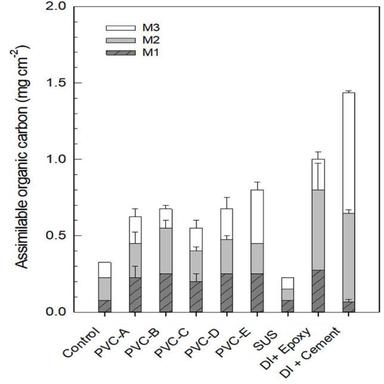
Assimilable organic carbon migration potential for the selected pipe materials at 25 ◦C. M1, M2, and M3 represent three test cycles (3 d per cycle). The tests were conducted in duplicates. The error bars indicate standard deviation.